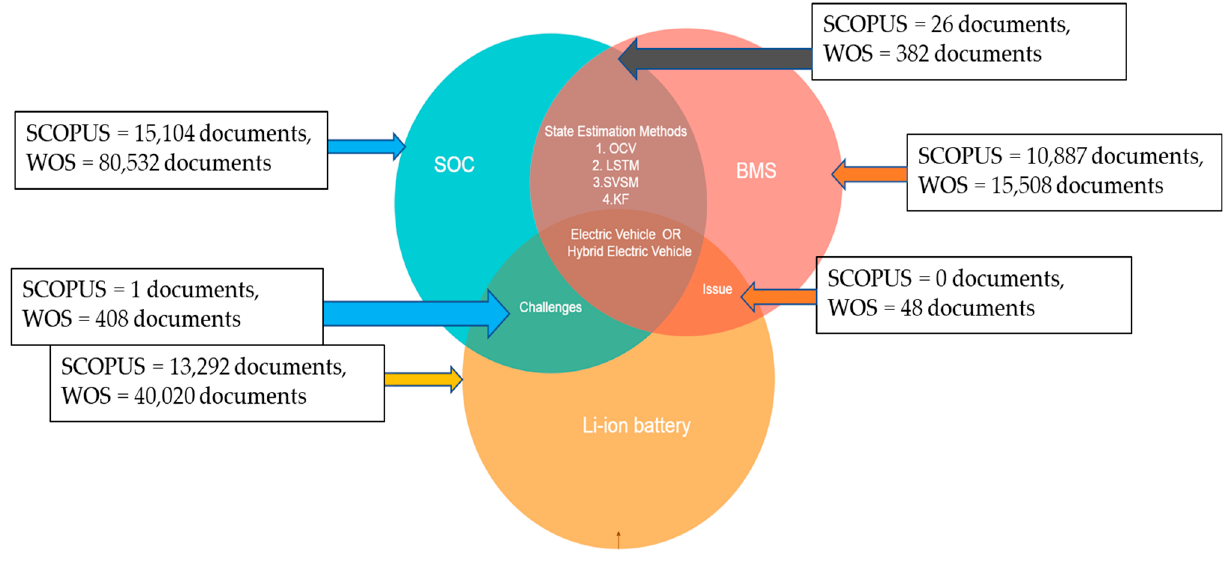
Figure 11. Critical analysis of top cited paper of SCOPUS and WOS. World Electr. Veh. J. 2022 , 13 , x FOR PEER REVIEW